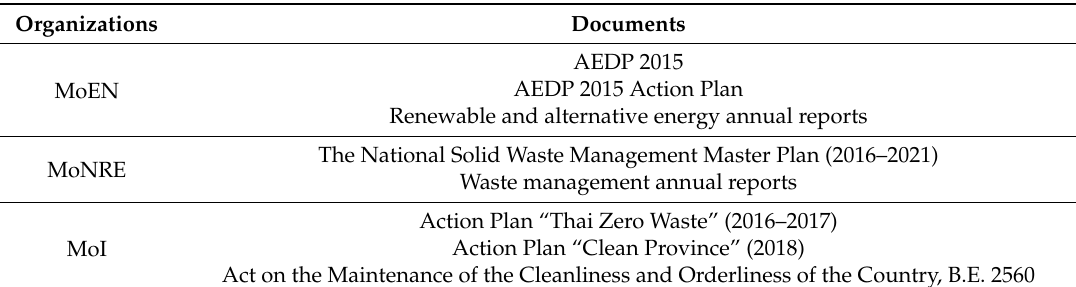
Table 1. Sources of information related to energy-from-waste (EFW) support and development by the Thai government. AEDP—Alternative Energy Development Plan; MoEN—Ministry of Energy; MoNRE—Ministry of Natural Resources and Environment; MoI—Ministry of Interior.